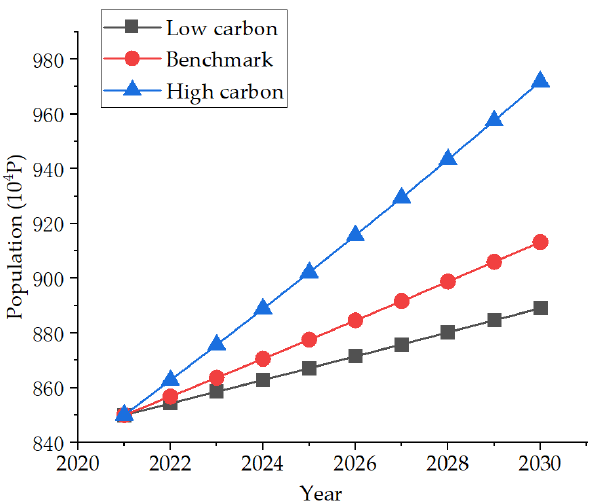
Figure 5. Three population development scenarios.